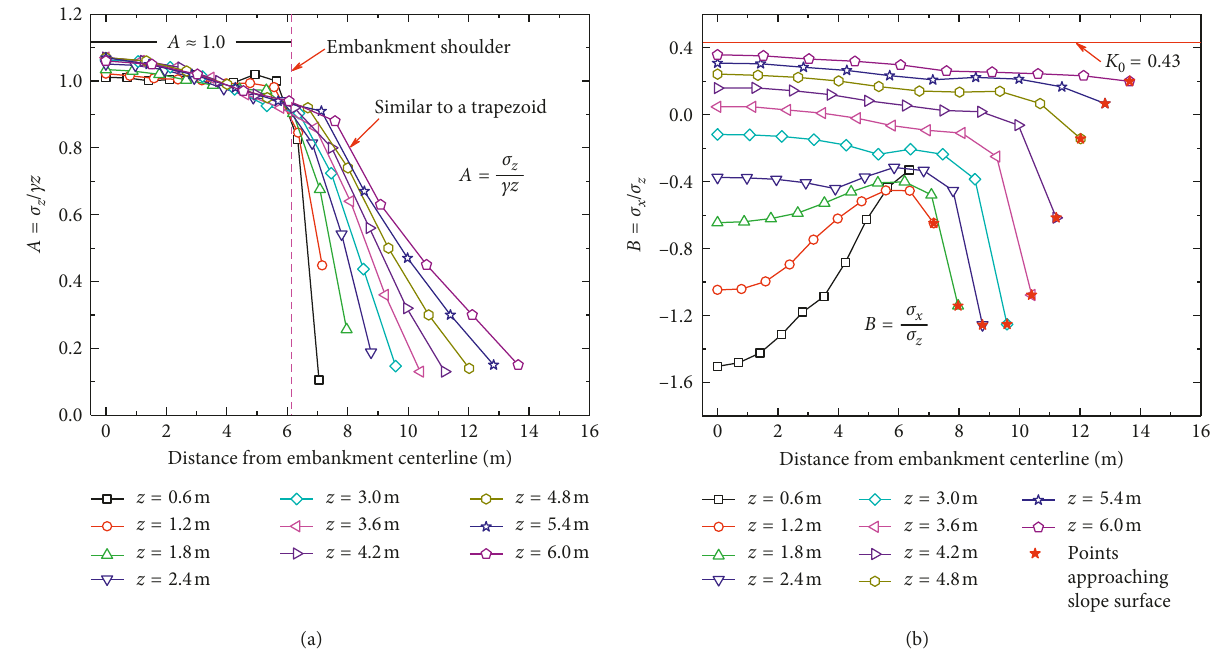
Figure 3: Initial stress distribution in a soil embankment: (a) A